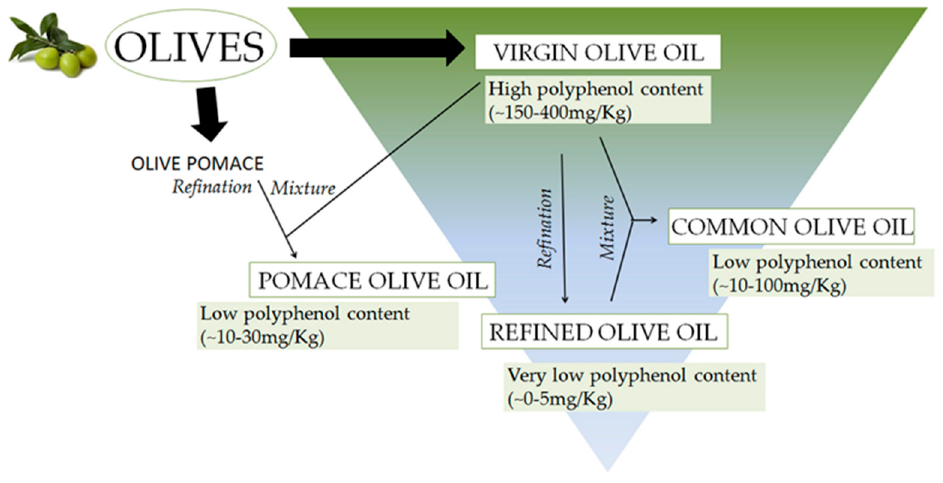
Figure 1. The concentration of polyphenols in differnet kinds of oilve oil depending on technological process of the oil extraction [25].